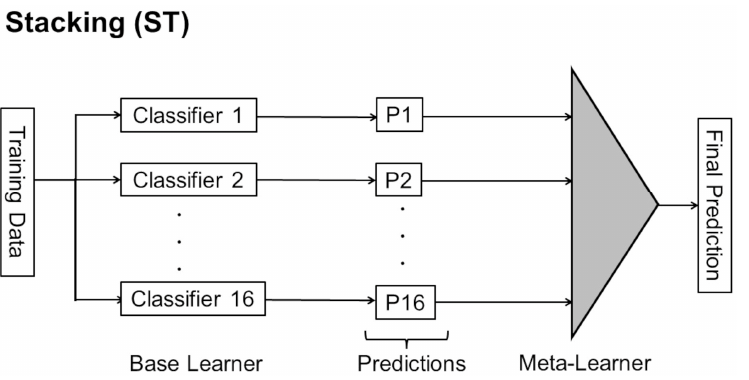
Figure 4. Description of ST. 16 different CNNs as base learner and LightGBM as meta-learner were used in this study.